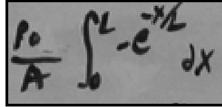
FIG. 8. Equation set up by Alan.